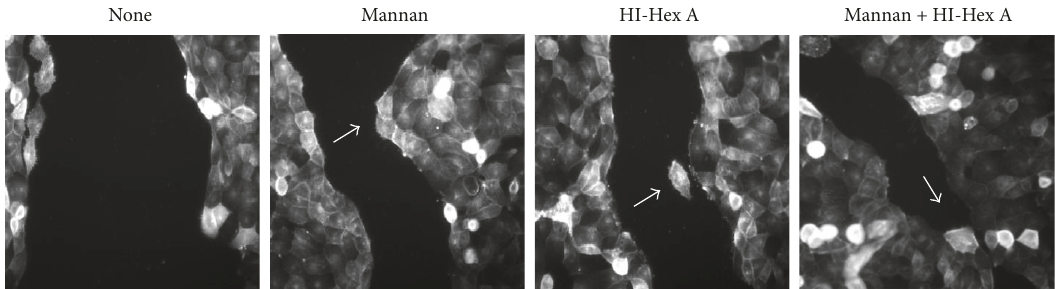
Figure 4: SC-MN and heat-inactivated (HI) Hex A facilitate wound closure in 16HBE cells. Digital images of cells after 17hrs incubation ( fi nal magni fi cation: 300x). Arrows: evagination of migrating wound edges.